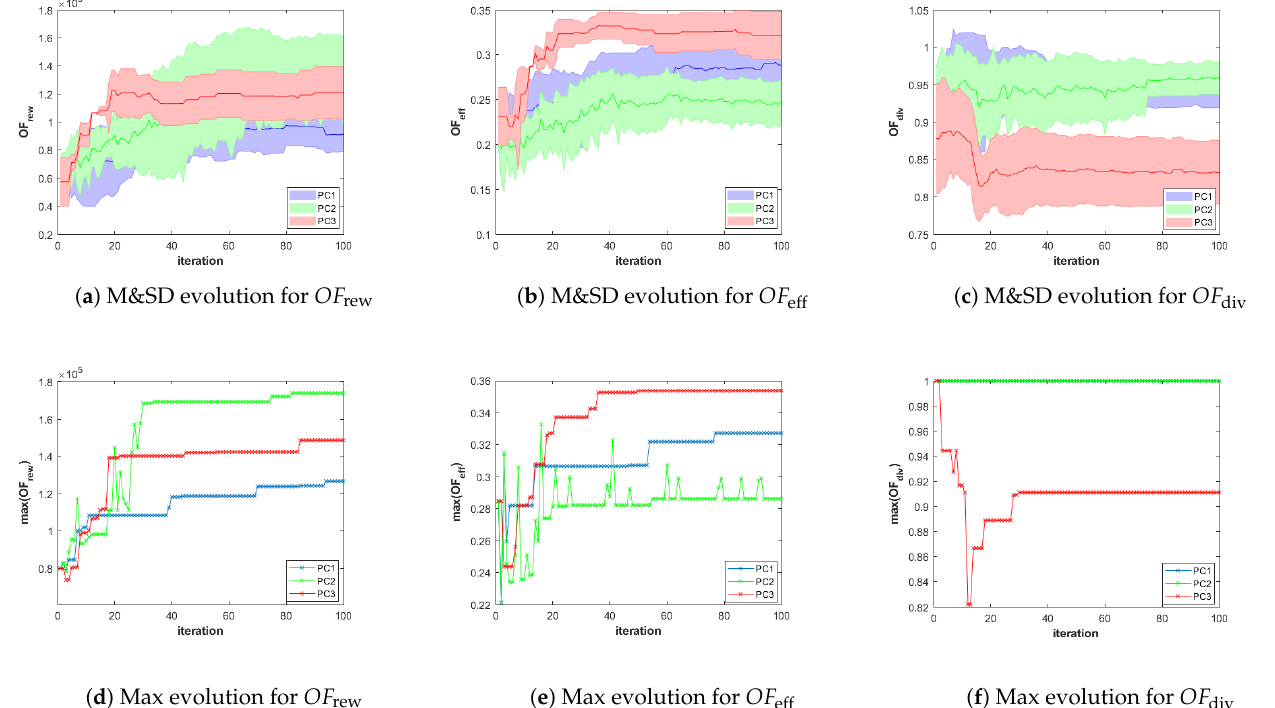
Figure 8. Evolution graphics of the OFs of the feasible solutions of the best Pareto front for SC1. The top row of graphics shows the evolution of the mean and standard deviation (M&SD) of each OF, while the bottom row shows the evolution of the best (Max) value of each